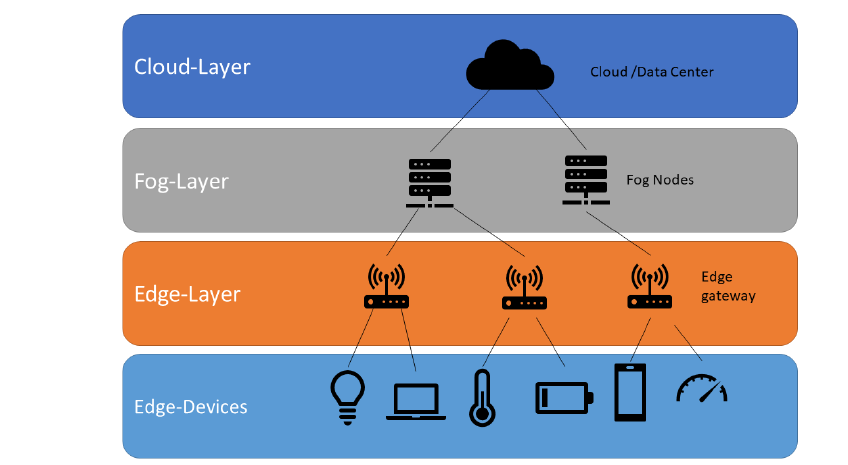
Figure 2. Fog computing approximation for Internet of Things (IoT) solutions. Figure available on